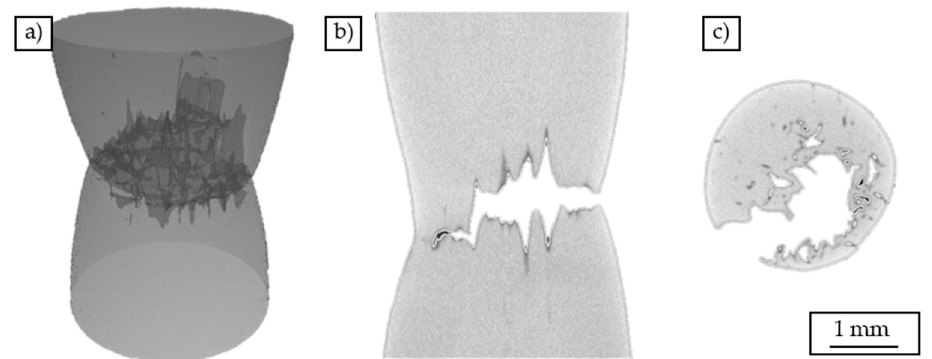
Figure 6. Volume reconstruction of chip-based specimen tested in a tensile test: ( a ) three-dimensional representation, ( b ) cross-sectional view parallel to the load direction, ( c ) cross-sectional view perpendicular to the load direction.